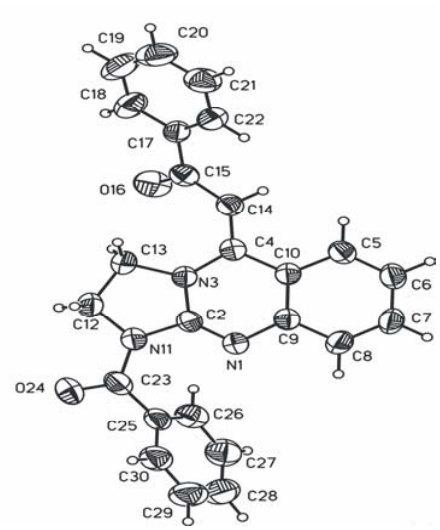
Figure 7 . ORTEP drawing of molecule 18 with atom labelling. Displacement ellipsoids were draw at 50% probability